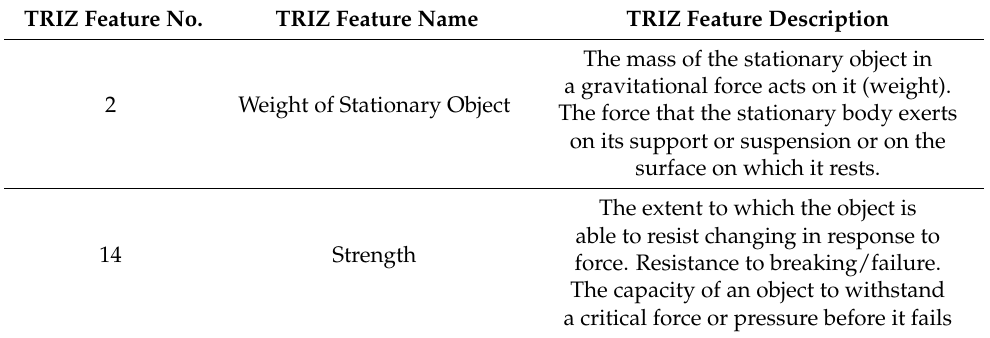
Table 1. TRIZ Features with contradictions from the HOQ Evaluation cited. TRIZ Feature No.